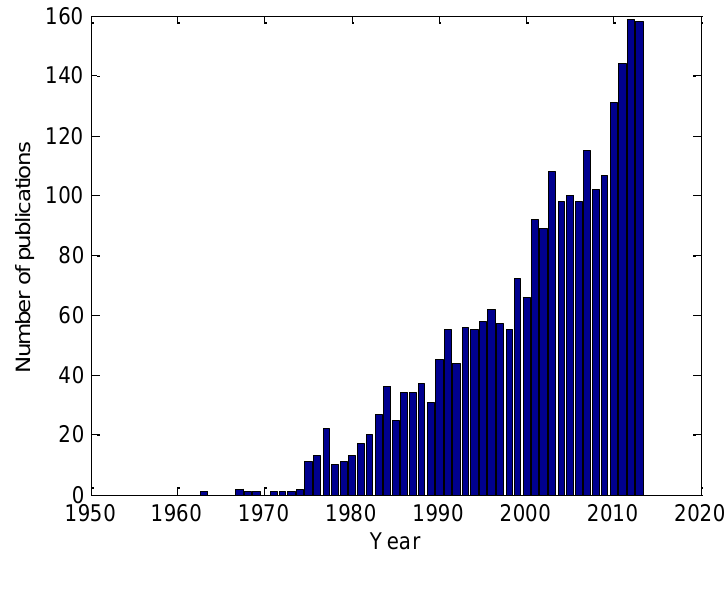
Figure 1: Number of published papers concerning fall detection through the years as listed in the Medline